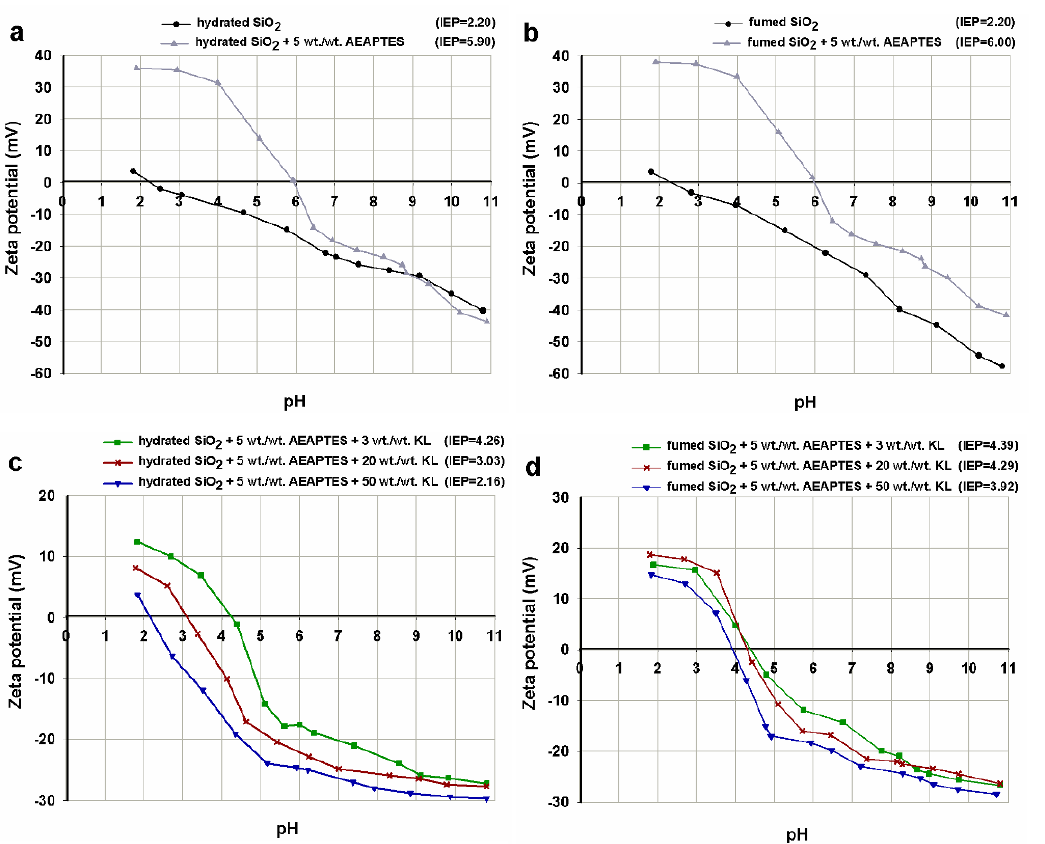
Figure 8. Zeta potential versus pH of unmodified and modified silicas (a, b), and silica/lignin hybrids obtained from hydrated silica (c) and Aerosil ® 200